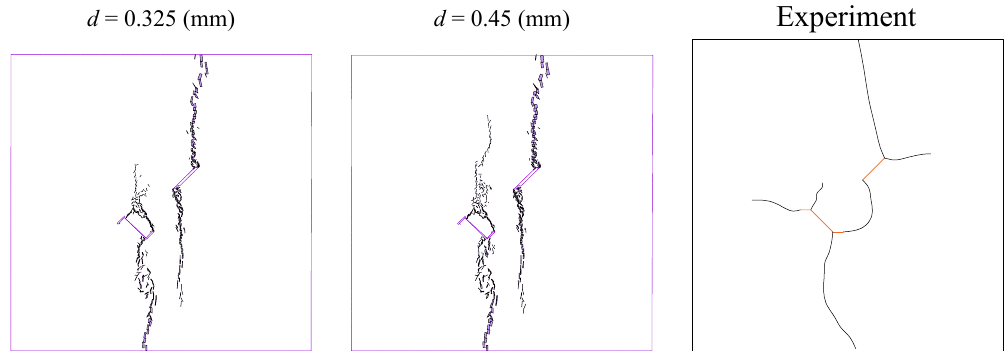
Figure 14. 3D-printed materials with two intermittent fissures ( α = 90 ◦ ): the crack opening plots (deformation scale 1:1) compared to the experimental results provided in [84].